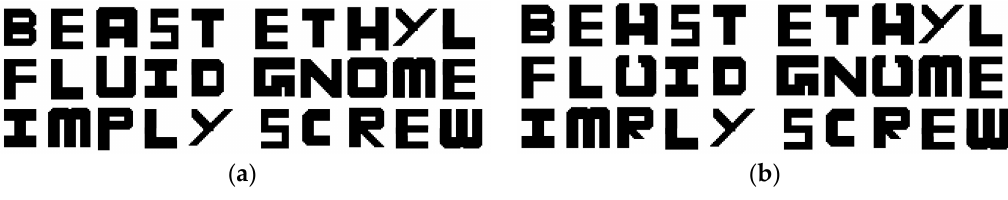
Figure 10. The training and test sets for the CINET(4) classifier ( a ) the noise-free context-augmented training set ( b ) the test set with the noise-free ambiguous center letters and noise-free congruent context.